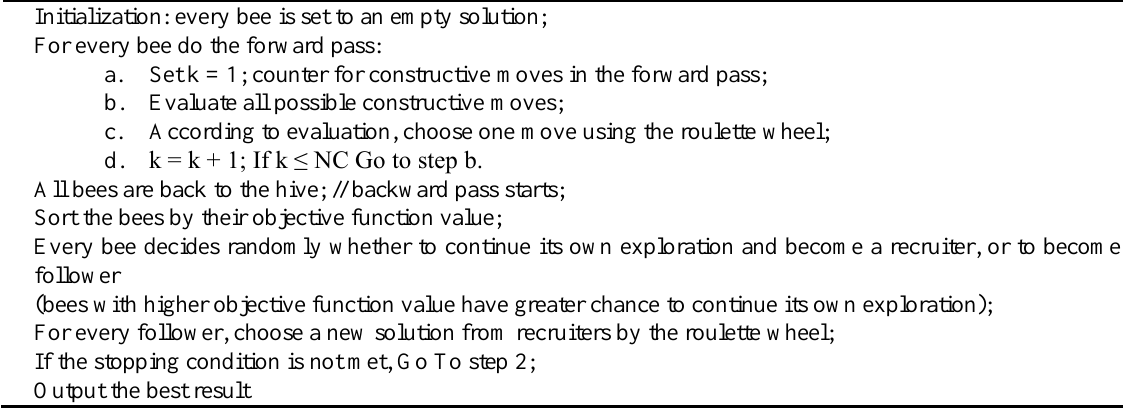
Figure 2. Pseudo code of Bee Colony Optimization (BCO)